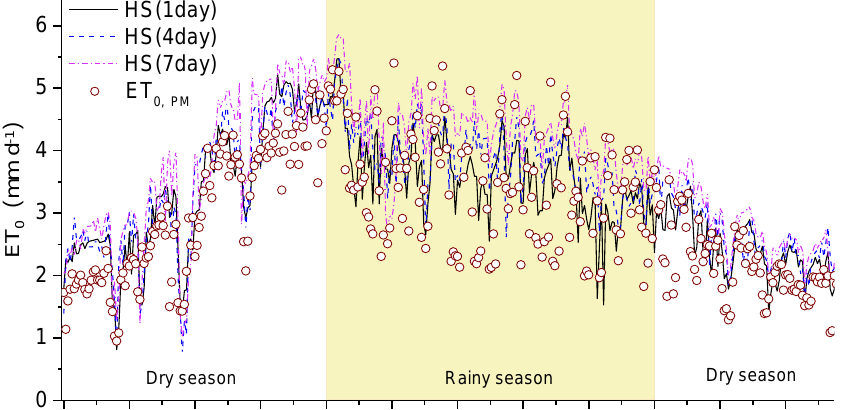
Figure 5. The ET 0 for 1-, 4-, and 7-day forecast periods and the daily variation of ET 0, PM in 2016